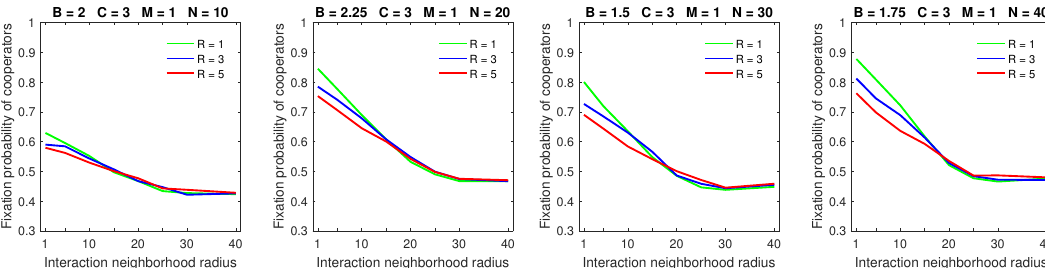
Figure 2. Increasing the dispersal range for low mobility rate M = 1 has a negative effect on the fixation probability of cooperators when the interaction neighborhoods are sufficiently small in the almost deterministic dispersal